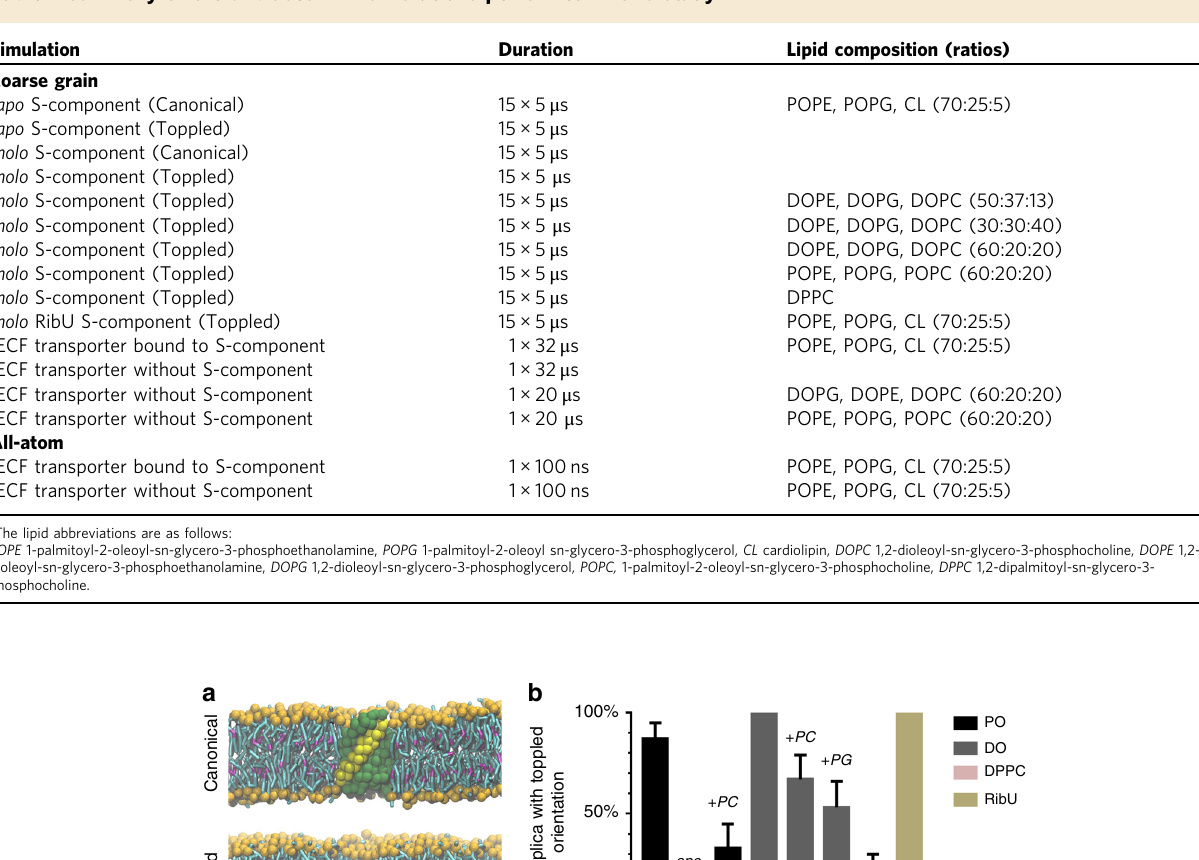
Table 1 Summary of the unbiased MD simulations performed in this study. Simulation